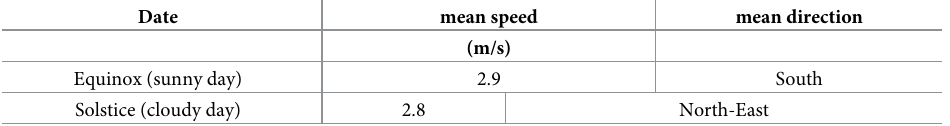
Table 3. Climate conditions of wind applied to this paper. The expected values follow the BCA Green Mark [42] at the reference height of 15 m based on the National Environment Agency’s 18-year data.